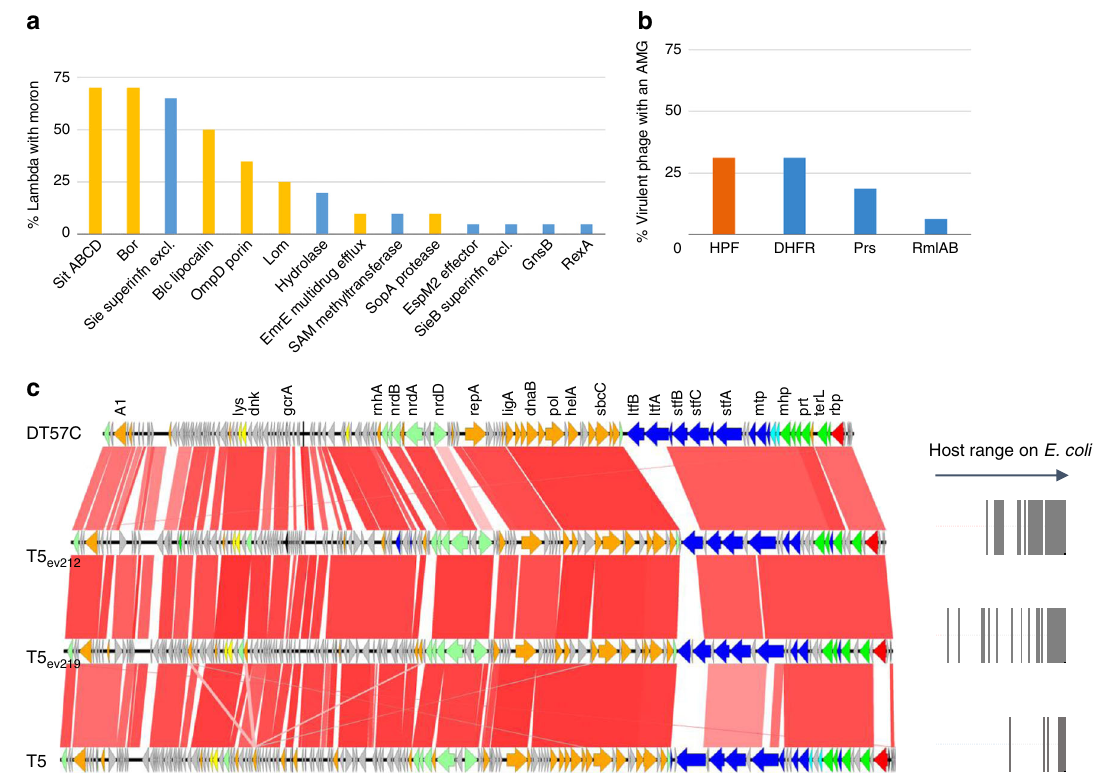
Fig. 5 Salient features of coliphage genomes. a Moron frequencies among 19 temperate Lambdaviruses. Yellow bars indicate membrane proteins and blue bars indicate other proteins. b AMG frequencies among 15 virulent sequenced phages. HPS, hibernation ribosomal protein; DHFR, dihydrofolate reductase; Prs, ribose-phosphate pyrophosphokinase; RmlA, glucose-1-phosphate thymidylyltransferase; RmlB, dTDP-glucose 4,6 dehydratase. c BLASTn alignment of four T5 genomes. The two T5-like phages isolated from viromes differ from T5 in their receptor-binding protein (p05 shown in red, similar to the DT57C gene), and from both DT57C and T5 in their L-shape tail fi bers. The shade of red signals identity level (66 – 100%). Right panel: gray bars stand for strains on which each T5 grows (taken from Fig.